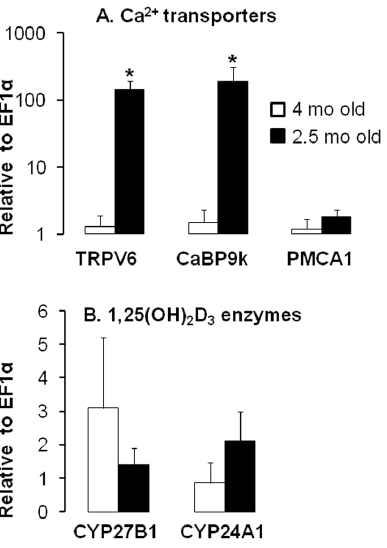
Figure 5. Effects of age on expression of intestinal Ca 2 + transporters and of renal 1,25(OH) 2 D 3 metabolic enzymes in mice. A comparison of the expression levels of Ca 2 + transporters ( A ) and 1,25(OH) 2 D 3 metabolic enzymes ( B ) in four mo old mice after three mo of feeding on normal Ca 2 + diet containing 63% glucose (from study 2) and in two mo old mice fed a normal Ca 2 + diet containing 43% glucose for five wk (from study 1). All expression data were analyzed by real-time PCR using EF1 a as a reference and normalized relative to levels seen in four mo old mice. Data are means 6 SEM ( n =5–6 per group). Differences ( P , 0.05) between means are indicated by asterisks. Expression of intestinal Ca 2 + transporters decreases with age.